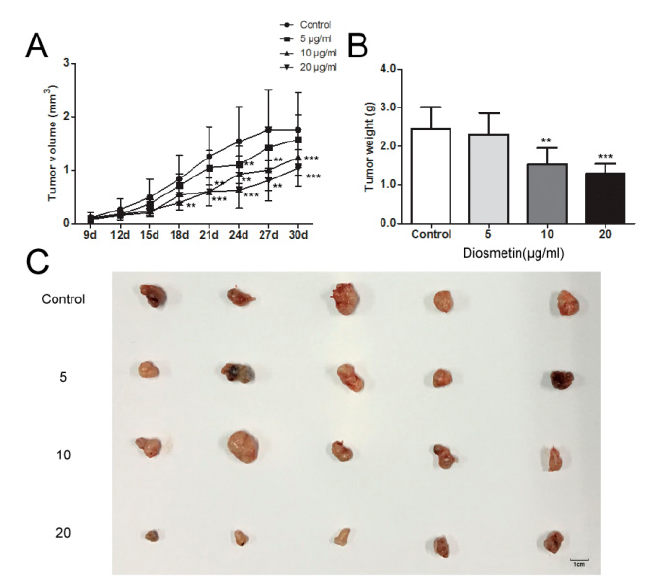
Figure 5. Diosmetin inhibited glioma tumor growth in vivo. ( A ) Tumor volume assay, ( B ) tumor weight assay, and ( C ) the photo of the tumor tissue. This figure shows the typical result of repeated experiments, and the data are presented as the mean ± standard deviation. Compared with the control group, ** p < 0.01, *** p < 0.001.